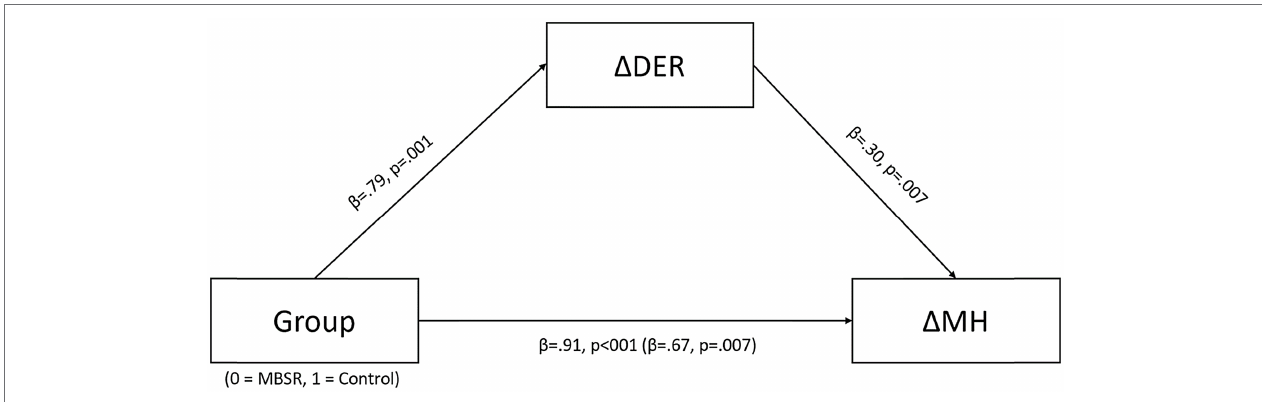
FIGURE 4 | Mediation of intervention group on changes in mental health through changes in emotion regulation (the models present standardized beta coefficients). a ∆ DER = difficulties in emotion regulation measured at T3 – difficulties in emotion regulation measured at T1/difficulties in emotion regulation measured at T1. b ∆ MH = the combined standardized score of state anxiety and perceived stress at T3 – the combined standardized score of state anxiety and perceived stress at